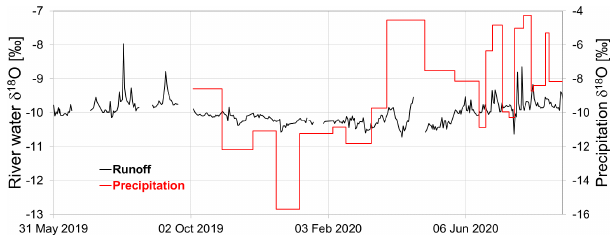
Figure 11. Precipitation and river water δ 18 O isotopes at site